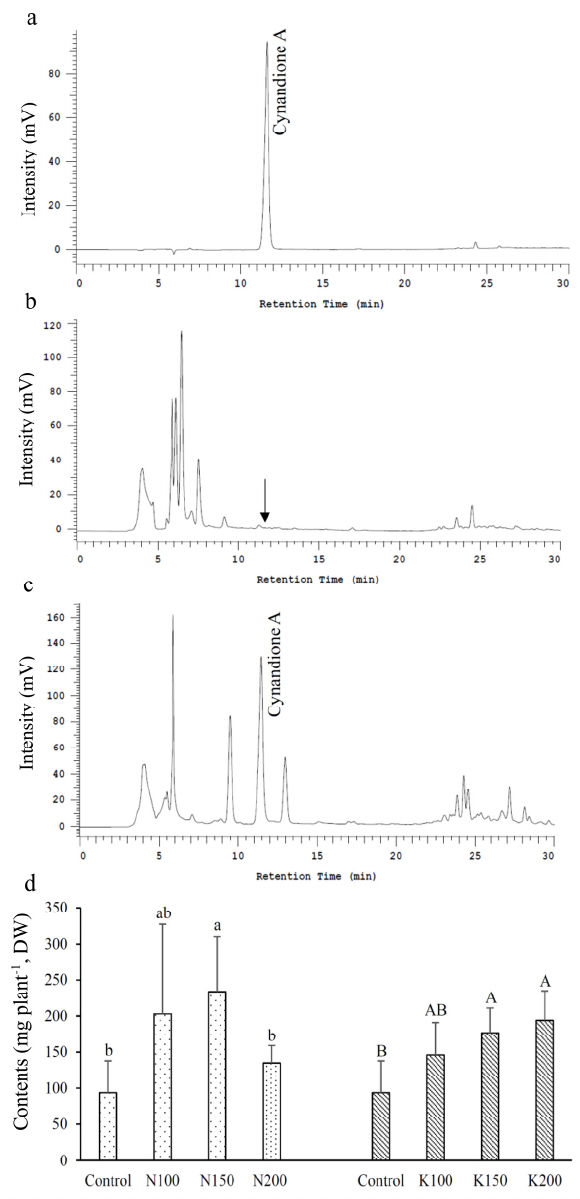
Figure 5. Chromatograms and contents of cynandione A in C. taiwanianum shoots and roots: ( a ) standard, ( b ) shoot, ( c ) roots, ( d ) cynandione A content in roots of C. taiwanianum . Values are mean ± standard deviation ( n = 4). The bars with different letters within the same fertilizer treatment (N treatments: Control, N100, N150 and N200; K treatments: Control, K100, K150 and K200) are signif- icantly different ( p < 0.05, LSD tests).